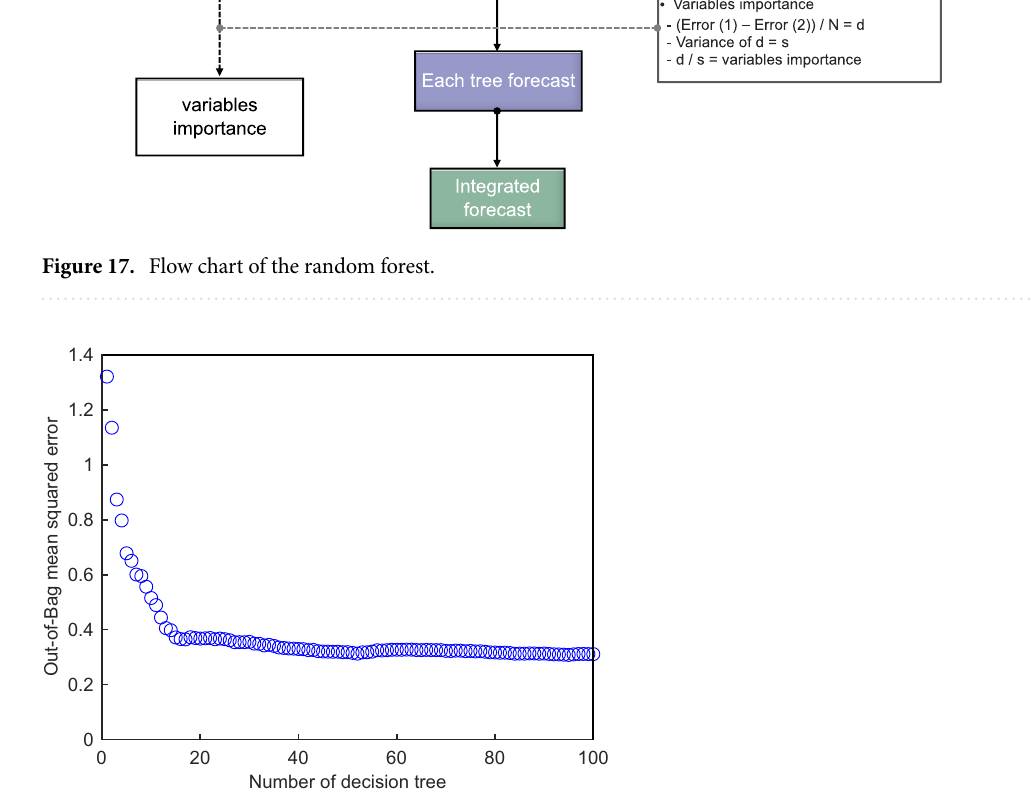
Figure 18. Out-of-bag refers to the squared error according to the number of